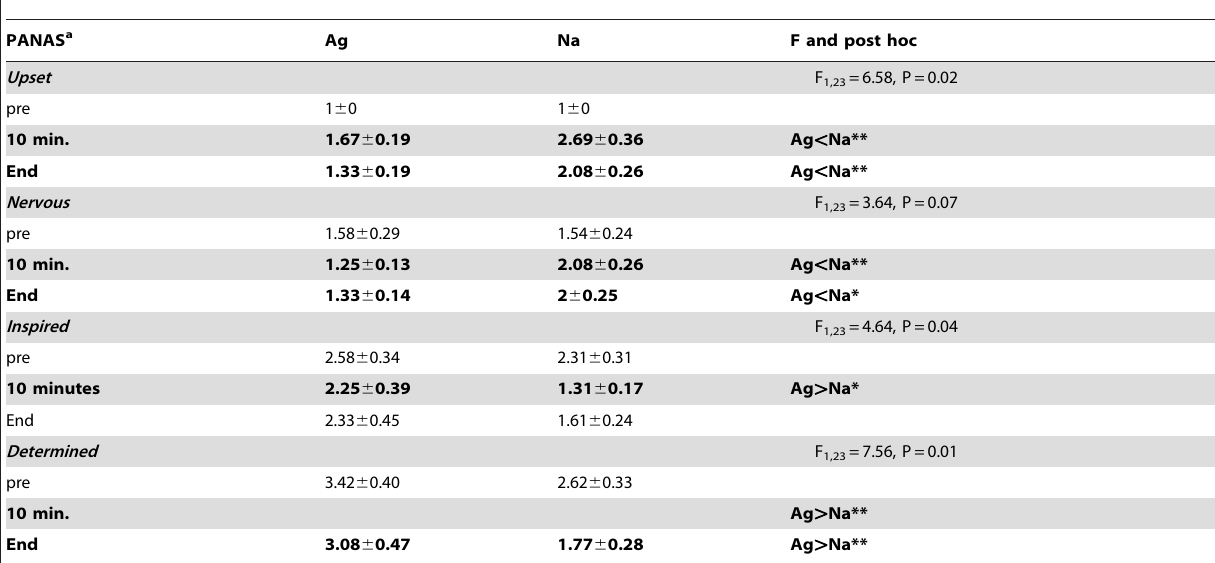
Table 3. Emotional reactivity during the violent media presentation.